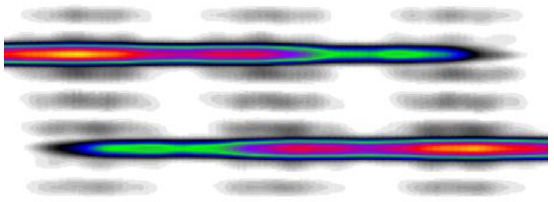
Figure 13. Diagram of the power propagation in the X-Z plane when the core mode was completely dropped.